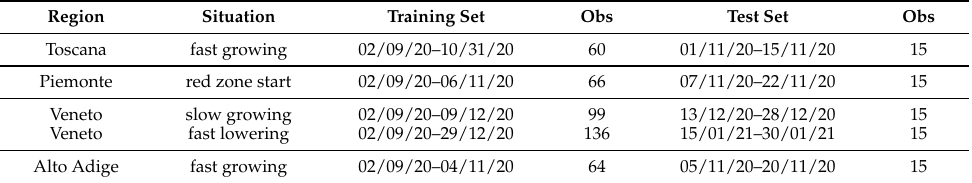
Table 3. Forecasting dates in different situations: training and test